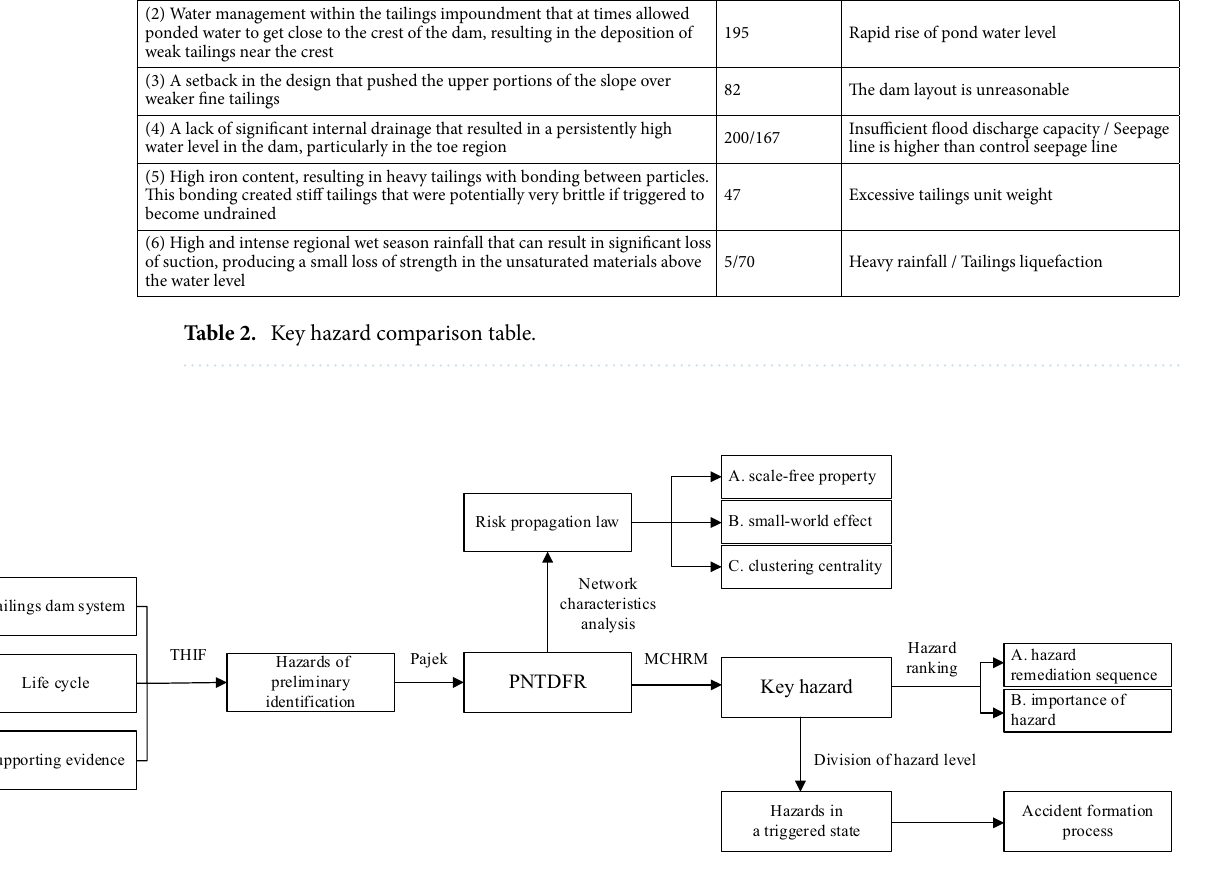
Figure 8. A flow chart showing the full-text research methods and